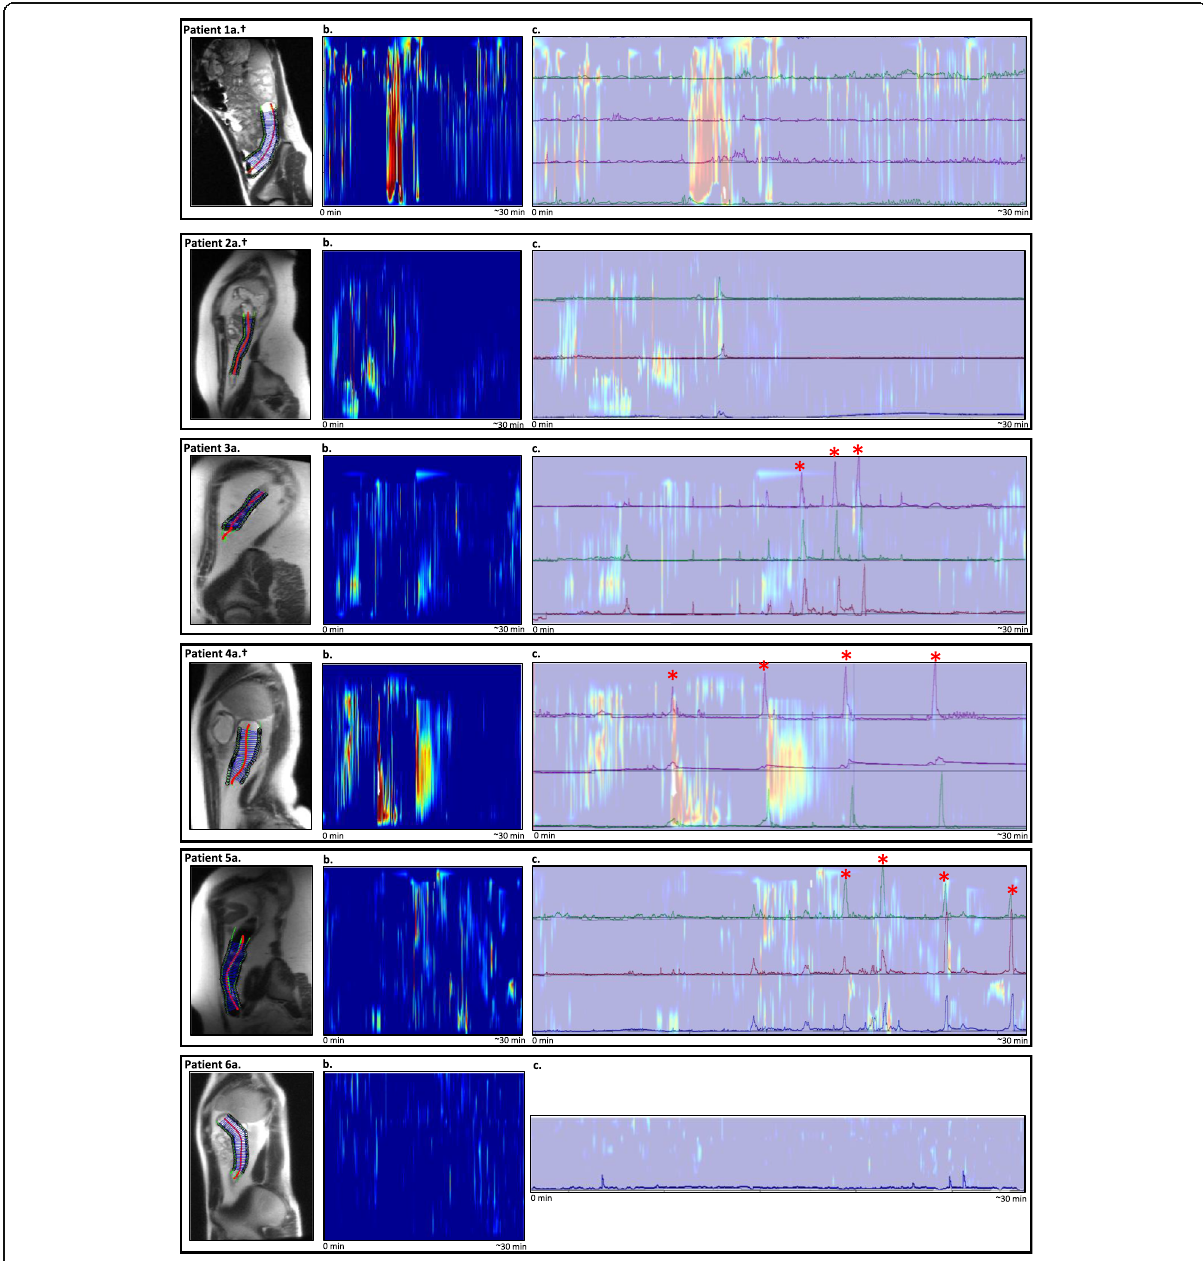
Fig. 2 Simultaneous colonic manometry and cine magnetic resonance imaging (cine-MRI) motility results. The figure displays: ( a ) a sagittal view of the child showing the region of interest in the descending colon; ( b ) the results of about 30 min of cine-MRI colonic activity. Recording time in minutes is displayed on the x -axis. Colonic activity is reported on the y -axis, with red colours representing a small diameter (contraction) and blue colours no change in diameter; and ( c ) the about 30 min of colonic manometry recordings with an overlay of simultaneous cine-MRI results as shown in b , to allow for a visual comparison of high-amplitude propagating contractions (HAPCs). The x -axis displays the time from the start of simultaneous cine-MRI imaging (0 min) to the termination of the cine-MRI recordings (about 30 min). The y -axis displays the manometric channels in the descending colon with pressure changes (in mmHg), overlapping the cine-MRI motility results as shown in b . ± Patient with caecostomy in place, *